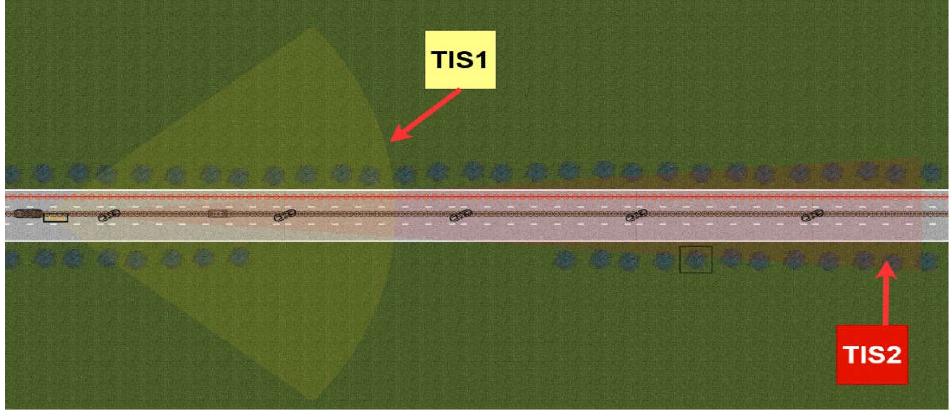
Figure 5. Short-range sensor (TS1) and long-range sensor (TS2) in vehicle A.